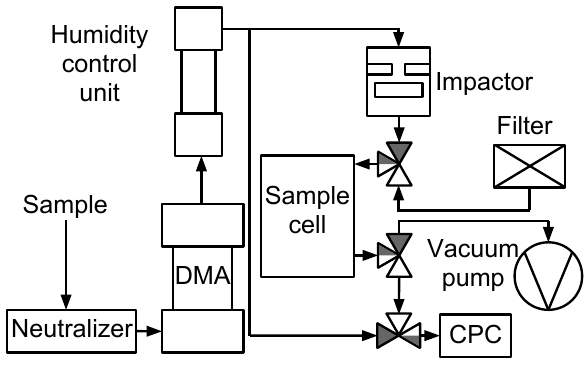
Fig. 1. Measurement setup used in the DRH experiments. The dark route through valves denote the sampling period and white route the measurement